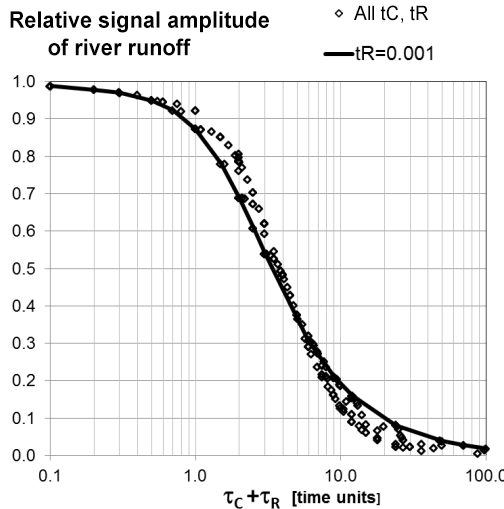
Figure 3. Signal amplitudes of total mass normalized by recharge: σ MT /σ N versus total mass time constant τ T = τ C + τ R for different river time constants τ R .